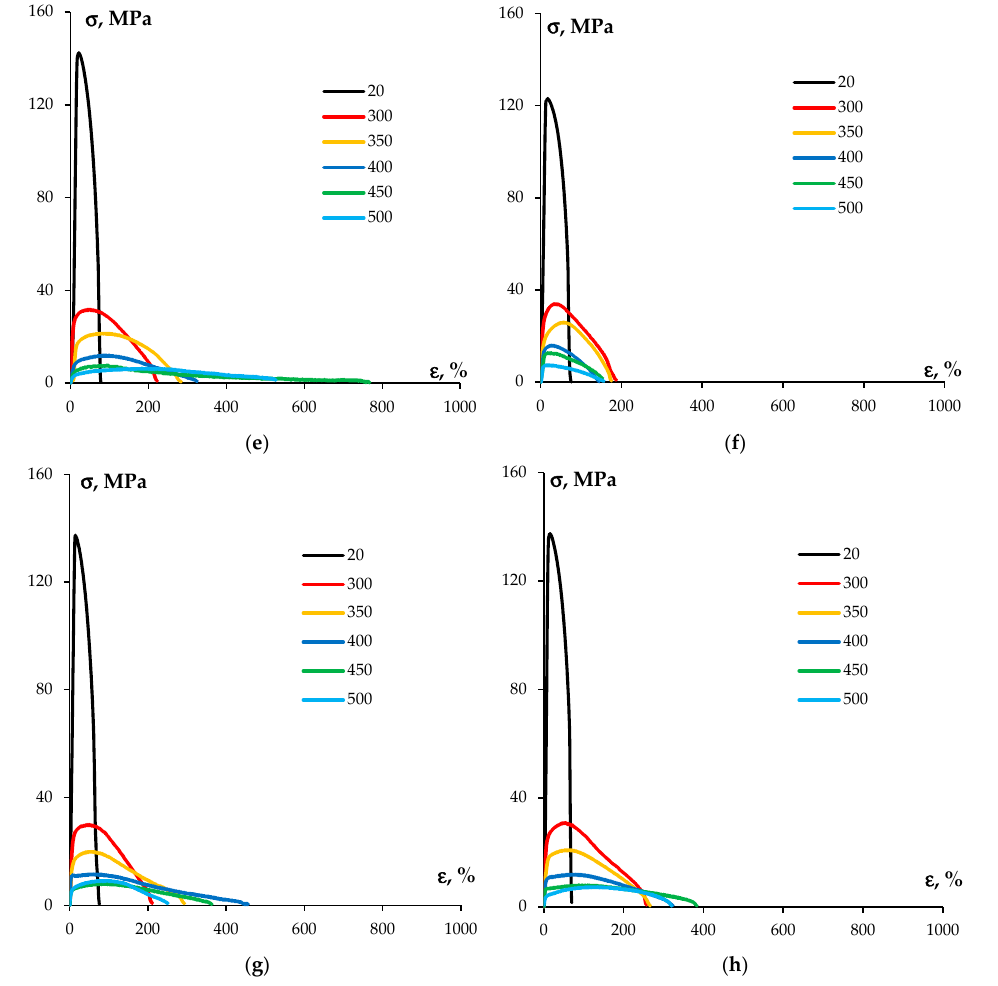
Figure A2. σ ( ε ) curves in UFG alloys series No. 1 ( a ), 2 ( b ), 3 ( c ), 4 ( d ), 5 ( e ), 6 ( f ), 7 ( g ), and 8 ( h ). Tests at elevated temperatures and a strain rate of 3.3 × 10 − 3 s − 1 . Test temperatures are provided in the figures.